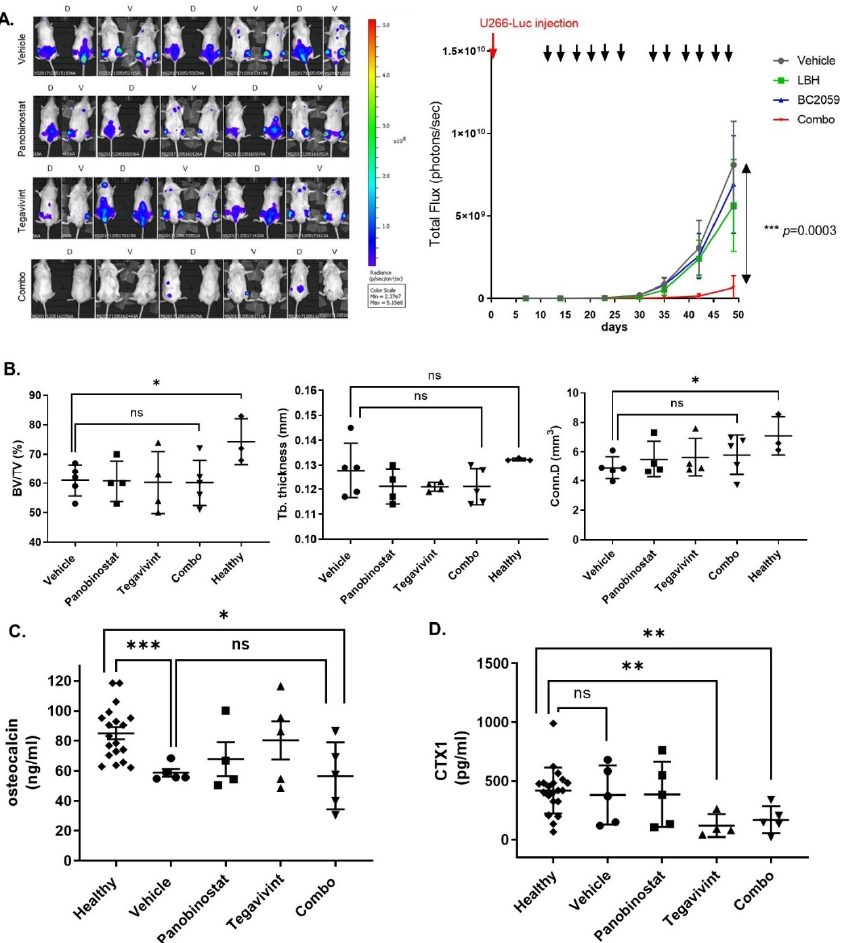
Figure 6. Tegavivint in combination with panobinostat exerts potent anti-MM effect in vivo, without a negative impact on bone metabolism. ( A ) NSG human MM-bearing mice received vehicle (17% Solutol HS 15 (Sigma-Aldrich) and normal saline) ( n = 5), whereas treated mice received 10 mg/kg panobinostat ( n = 5) or 30 mg/kg Tegavivint ( n = 5), or their combination ( n = 5) twice a week intraperitoneally for 3 consecutive weeks for 2 cycles of 28 days each. Tumour growth was monitored weekly with in vivo bioluminescence imaging. Dorsal (D) and ventral (V) views of NSG human MM-bearing mice at day 49 (end of cycle 2 treatment). The median flux (photons/second) of dorsal and ventral views for each cohort is documented ( n = 5 for each cohort, ± SD). Multiple t -tests were used for statistical analysis without assuming SD, and statistical significance was determined using the Holm-Sidak method, with α = 5.000%. ↓ : therapeutic intervention. ( B ) Adult NSG human MM- bearing mice were treated as mentioned above for two cycles. Upon reaching experimental end point mice were humanely euthanised and micro-CT of L5 vertebrae was performed. BoneJ was used for the analysis and the calculation of bone morphometric indices and compared with the measurements derived from three healthy age matched NSG mice. Treatment with single drugs or the combination did not negatively affect the bone volume fraction (BV/TV), trabecular thickness (Tb. Thickness) or the connectivity density (Conn. D) (* p ≤ 0.05, nonparametric Mann-Whitney t test). ( C ) During the last week of cycle 2 serum was analysed for osteocalcin levels by ELISA. Derived values were compared with serum osteocalcin concentrations before the injection of U266-MM cells (healthy) (*** p = 0.0005 and * p = 0.02, nonparametric Mann-Whitney t test). ( D ) Similarly, serum was analysed for carboxy-terminal collagen crosslinks (CTX1) levels by ELISA. Derived values were compared with serum CTX1 concentrations before the injection of U266-MM cells (healthy) (** p = 0.005 and ** p = 0.008 for healthy versus Tegavivint or combination, respectively, nonparametric Mann-Whitney t